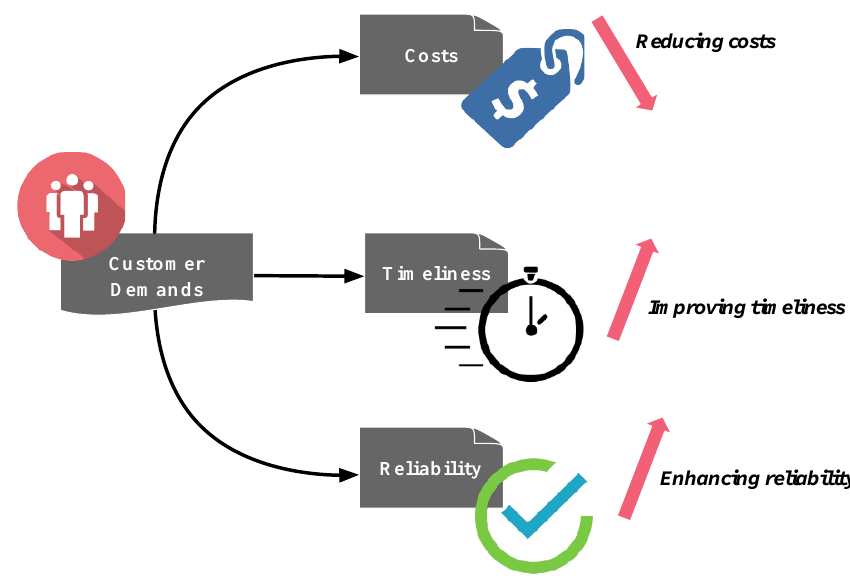
Figure 1. Customer demands in the road-rail intermodal routing.